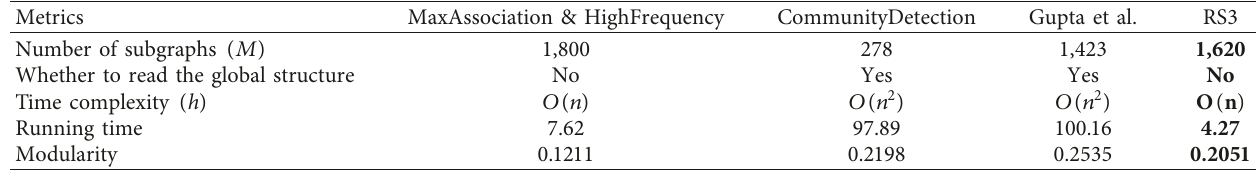
Table 3: Comparison of subgraph partitioning algorithms on WeiboData.